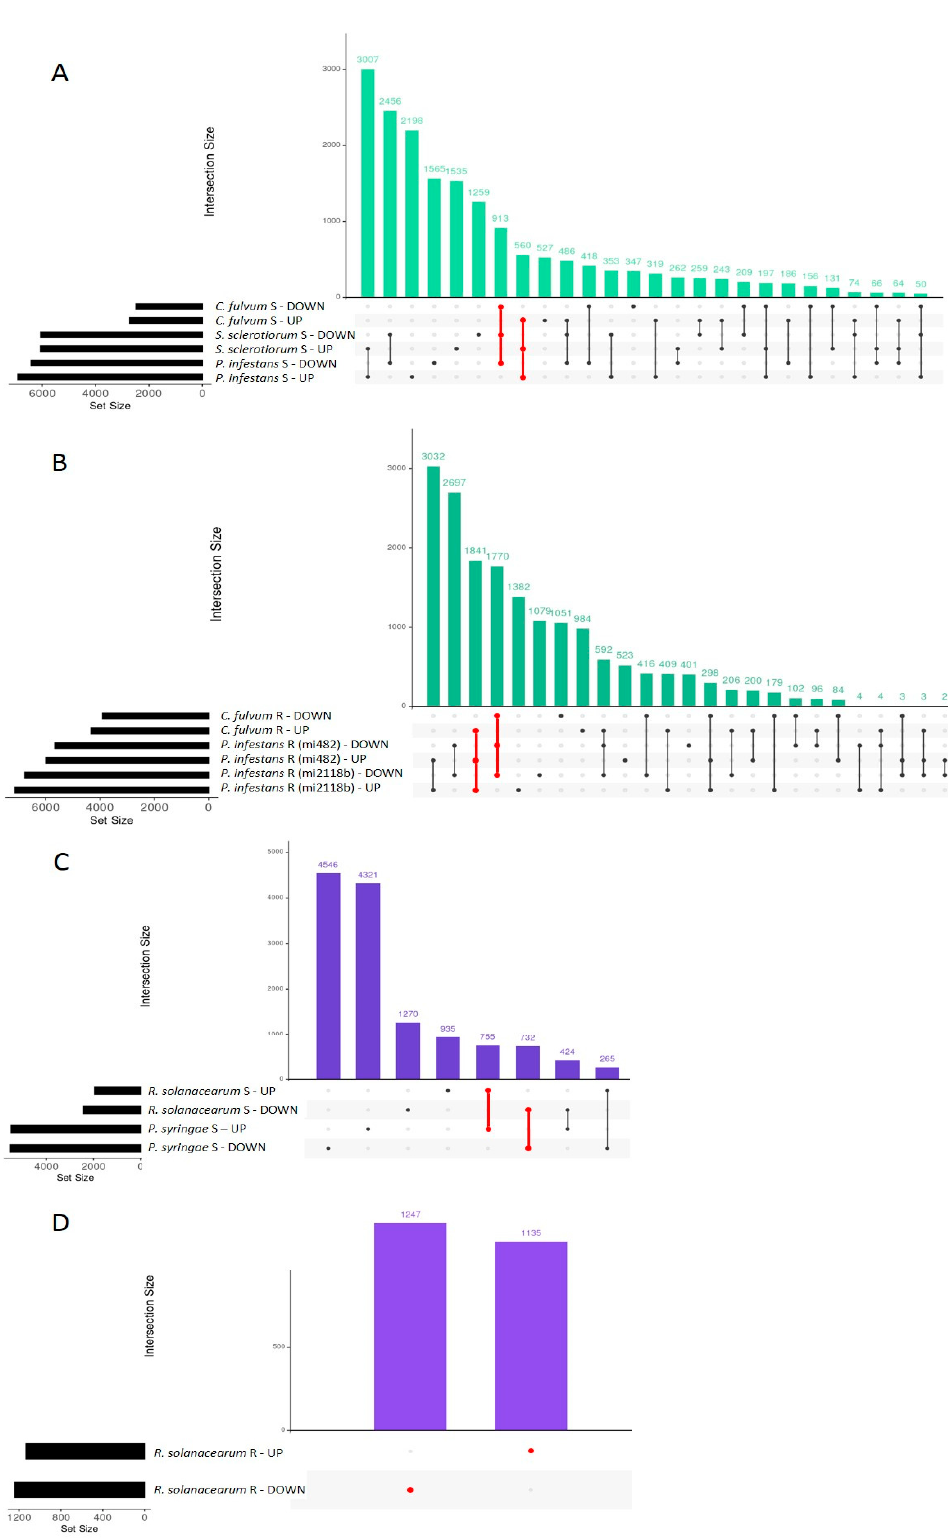
Figure 1. The intersection of up and down DEGs induced by tomato genotypes infected with fungi and bacteria (first 30 intersections). ( A ) Susceptible genotypes infected with fungi. ( B ) Resistant genotypes infected with fungi. ( C ) Susceptible genotypes infected with bacteria. ( D ) Resistant genotype infected with bacteria. In red are DEGs with the same expression trend in all the analyzed datasets.